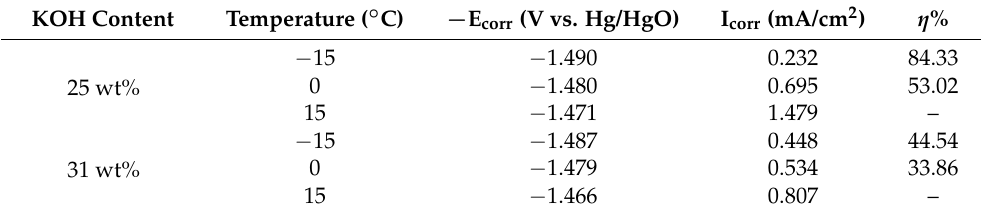
Figure 6. Potentiodynamic polarization curves for Al anodes measured in 25 wt% KOH: ( a ) and 31 wt% KOH; ( b ) at different temperatures. Table 1. Corrosion parameters of Al anodes in KOH electrolyte at different temperatures.